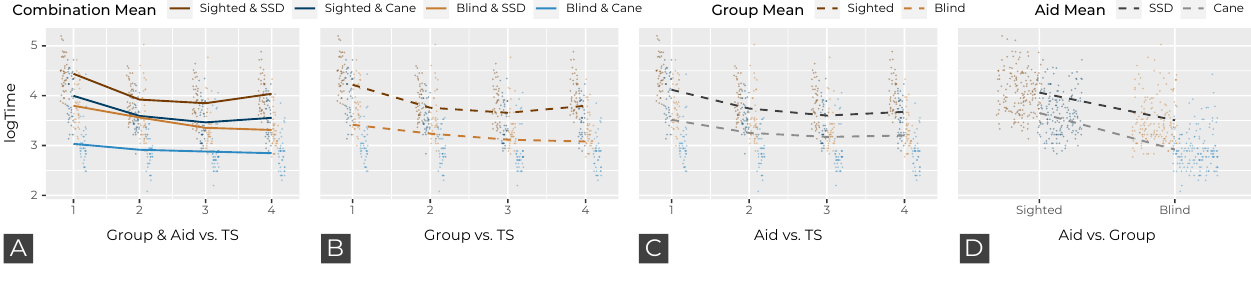
Figure A7. Interaction plot for several variable pairs show interactions in ( A ) group & aid vs. TS, ( B ) in group vs. aid, ( C ) a small interaction in aid vs. TS as well as one in ( D ) aid vs. group. With order being dropped and the other variables as well as the interactions being kept, the final model was this: